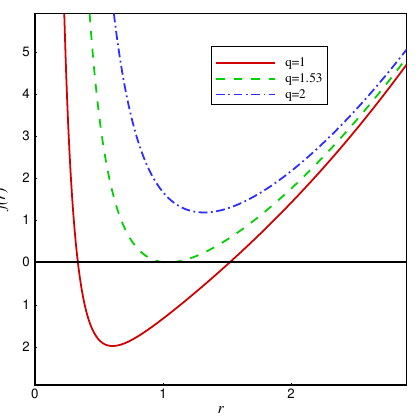
Figure 4 . The behavior of f ( r ) for charged rotating black string with di(cid:11)erent q , where we have taken m = 3, (cid:3) =